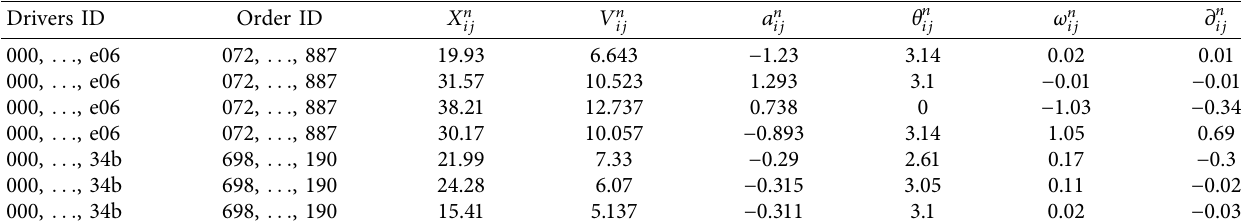
Table 2: Sample vehicle behavior data.